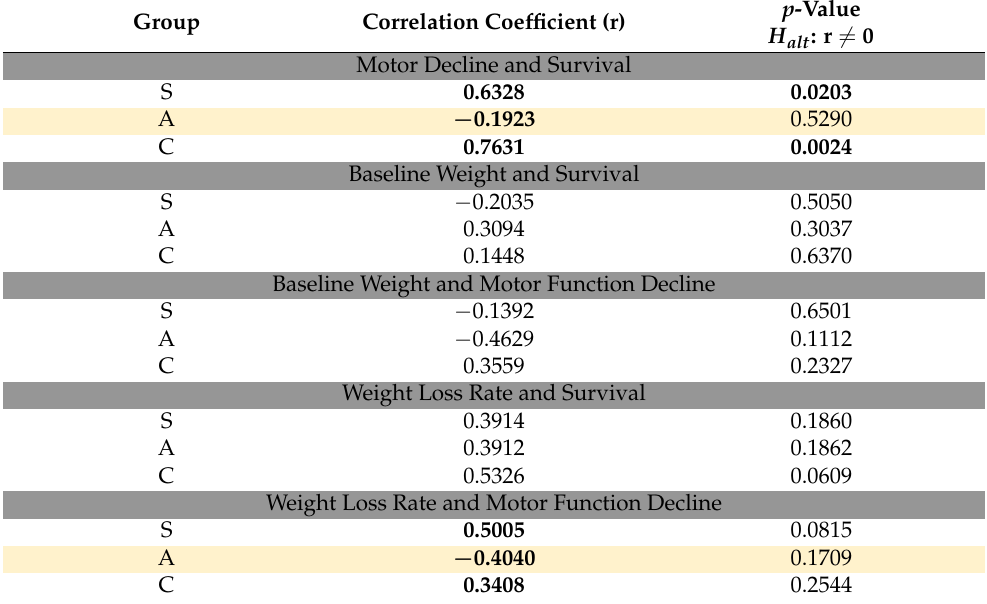
Table 3. Correlation coefficients (r) for each treatment group and the corresponding p value indicating whether the correlation is significantly different from 0. Coefficients of particular interest and p -values significant at an alpha of 0.05 are shown in bold text. The interesting deviations of the anodal group are highlighted in light